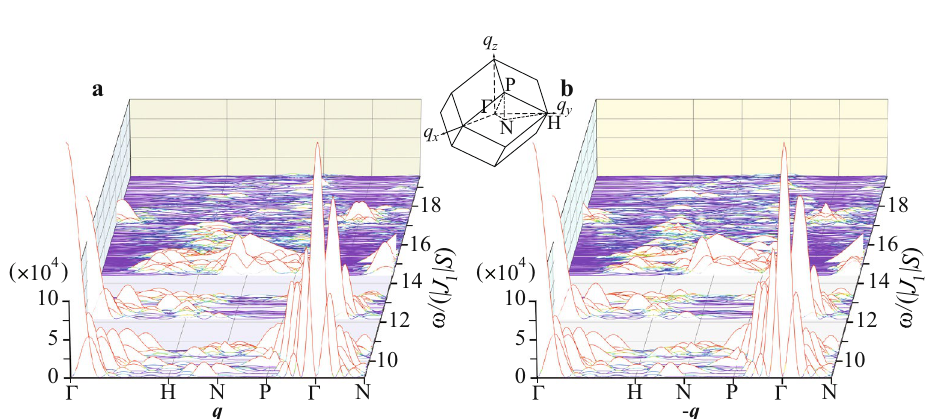
q , ω) in the QC. In ( a ) and ( b ), q is plotted −